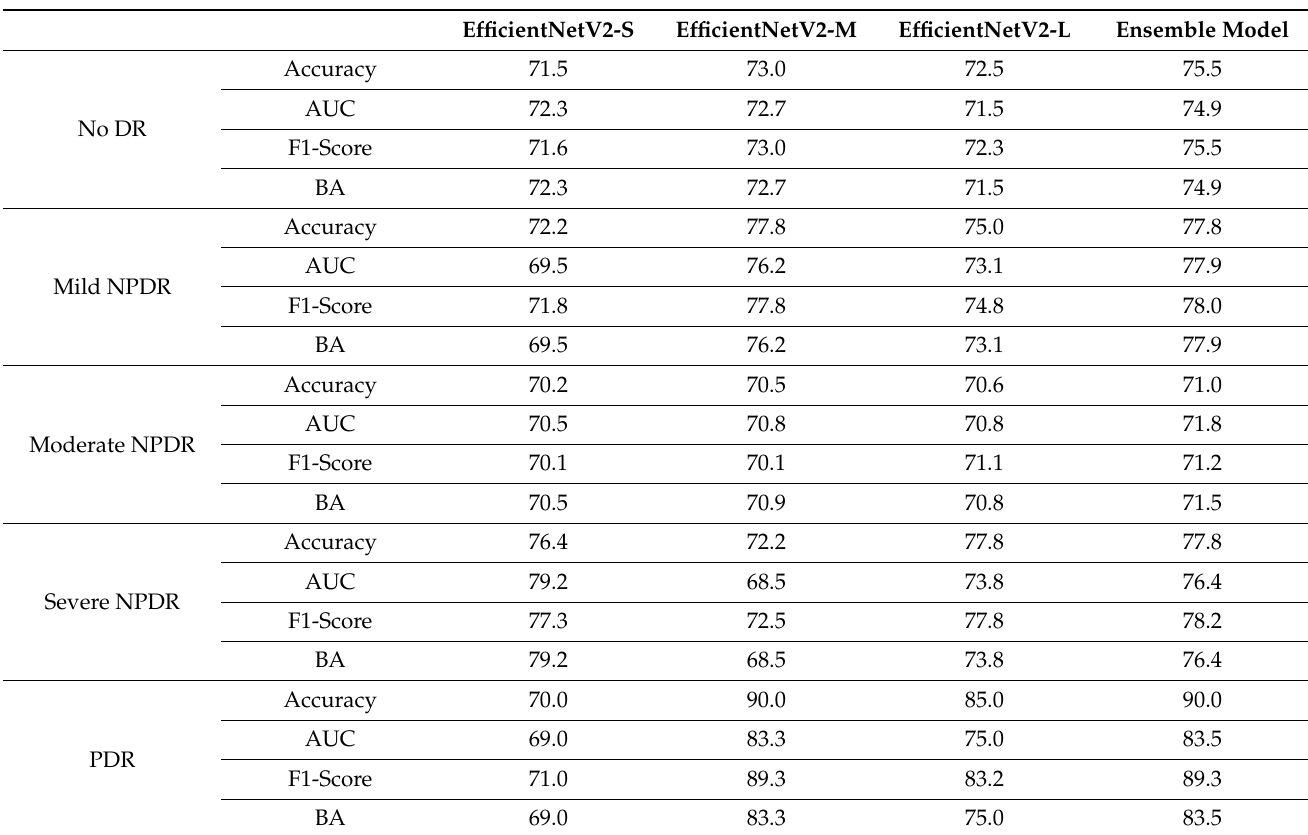
Table 5. Performance metrics for QE of test images stratified concerning DR severity for